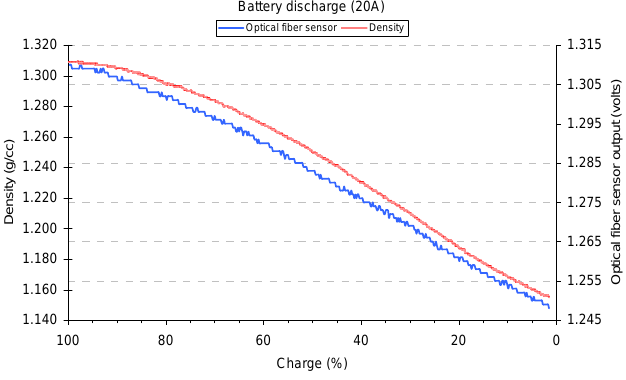
Figure 14. Measurements of the density of the electrolyte during the battery discharging process obtained from the optical fiber sensor (volts) and from the YUASA YPG-201 (gr/cc)